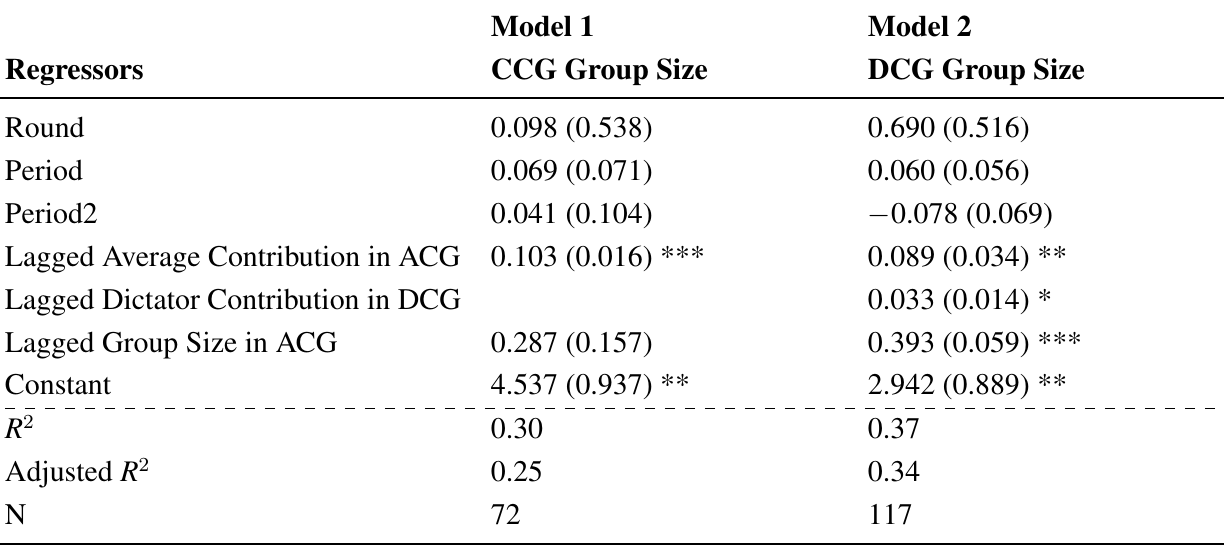
Table 2. Group size. The table shows the results of OLS regressions of the CCG and DCG group sizes on a number of regressors. Round is 1 (2) in the first (second) of the two 10-period sequences. Period2 equals the period number Period in round 2 and zero otherwise. The remaining variables are the lagged average contributions in the ACG and the lagged ACG group size (of the DCG in the regression of the dictator treatment, of the CCG in the analysis of the coordinator treatment) and the lagged contribution of the dictator in the